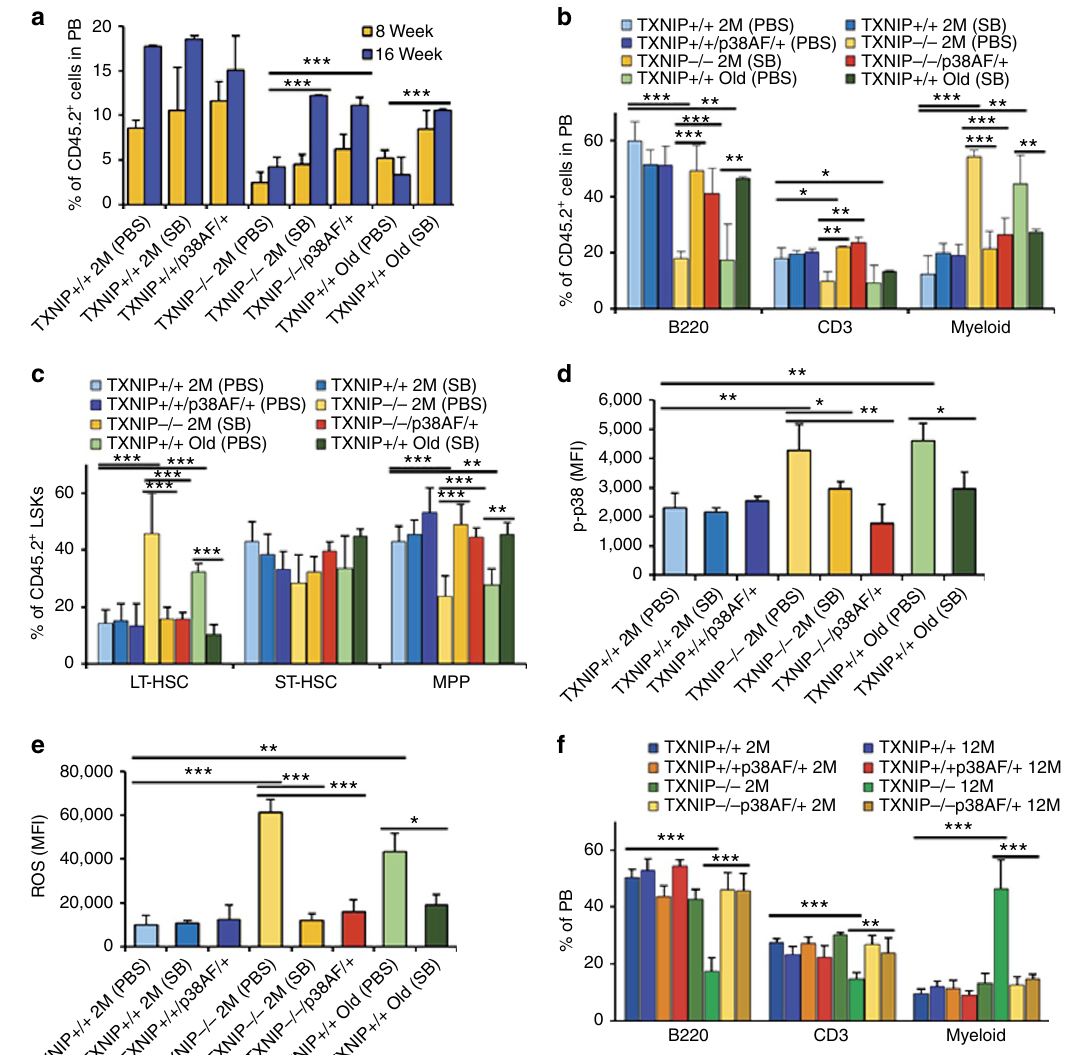
Figure 3 | Inhibition of p38 activity rejuvenates the defects of TXNIP (cid:2) / (cid:2) and aged HSCs in vivo. ( a , b ) Distribution of donor-derived WBCs in PB ( a ) and frequency of B220 þ , CD3 þ and myeloid cells among donor-derived WBCs in PB ( b ) ( n ¼ 6–7 from two experiments). ( c ) LT-HSCs, ST-HSCs and MPPs among donor-derived LSKs ( n ¼ 6–7 from two experiments). ( d ) Levels of phospho-p38 in donor-derived LT-HSCs were determined using flow cytometry ( n ¼ 6–7 from two experiments). ( e ) ROS levels in donor-derived LT-HSCs ( n ¼ 6–7 from two experiments). ( f ) LT-HSCs, ST-HSCs and MPPs among LSKs in 2- or 12-month-old mice ( n ¼ 5–8). Data are mean ± s.d. Statistical significance was determined using a two-tailed Student’s t -tests.